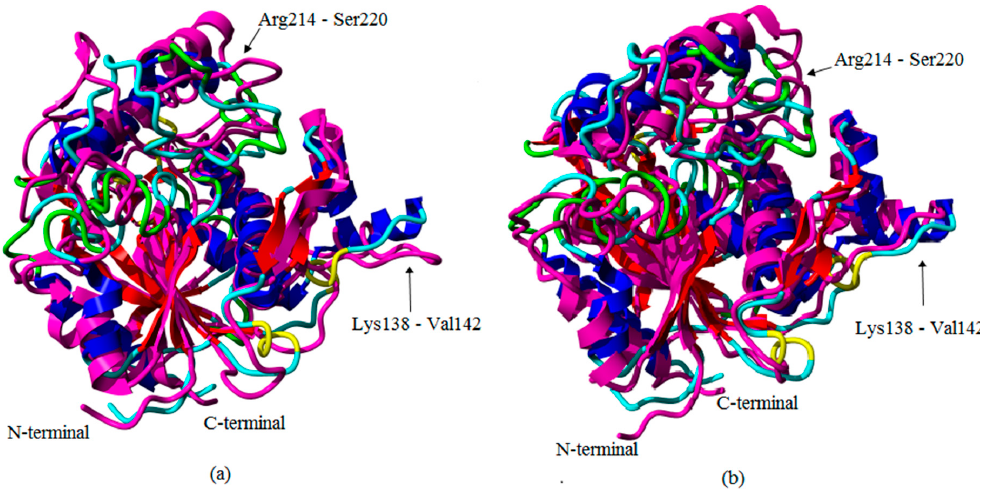
Figure 3. Superimposed T1 lipase structures before and after 20 ns of simulation: ( a ) Earth-grown structure at 0 ns (color in elements) and after 20 ns of simulation (color in magenta); ( b ) Space-grown crystal structure at 0 ns (color in elements) and after 20 ns of simulation (color in magenta). The arrows showed the region with a high flexible value in the earth-grown structure compared with the space-grown structure.